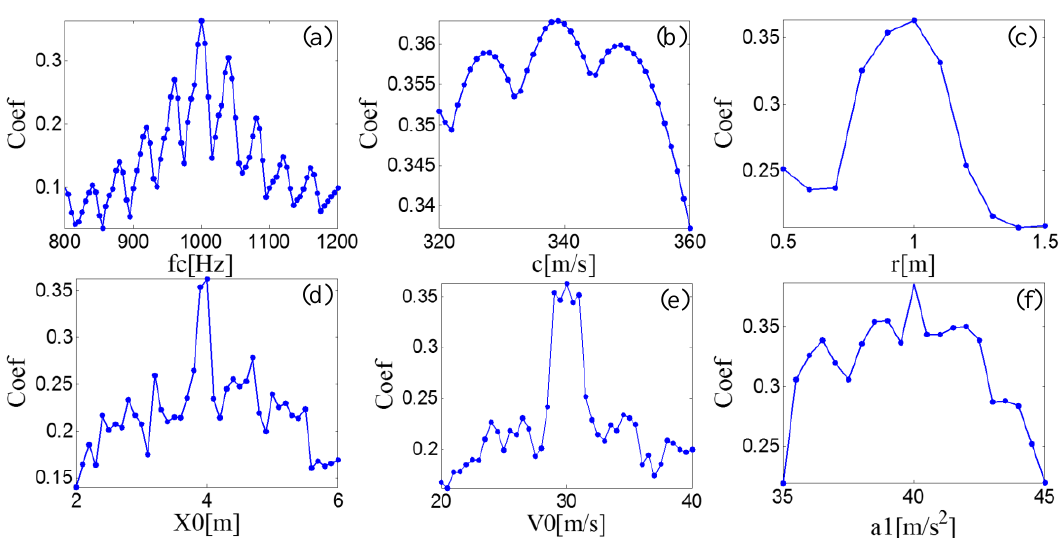
Figure 11. Maximal correlation coefficients for the different elements from a specified PMDW model parameter subset for the simulated signal.